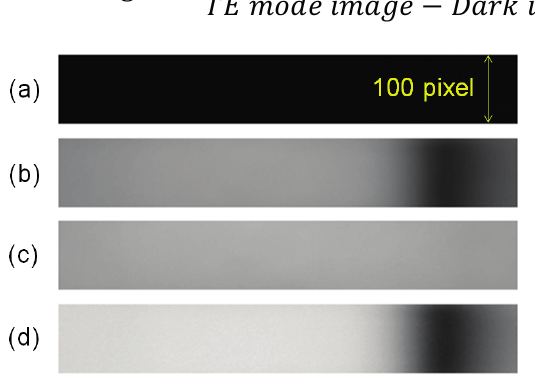
Figure 3. Images from a 2D CMOS image sensor: ( a ) The dark image is obtained when the incident light is turned off. ( b ) The TE-mode. ( c ) TM-mode images are obtained from the light-on mode when the polarizer is in TE-mode and TM-mode after the running buffer is injected on a gold sensor chip. ( d ) The final image is obtained after image processing using (a), (b), and